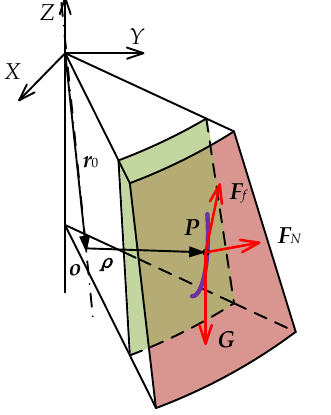
Figure 7. The force components of spatial sliding particle. As shown in Figure 7, the resultant force of particle P consists of three parts: the support force F N of the mantle surface, the friction force F f between the particle and the mantle surface and the gravity G of the particle, which can be expressed by Equation (23).